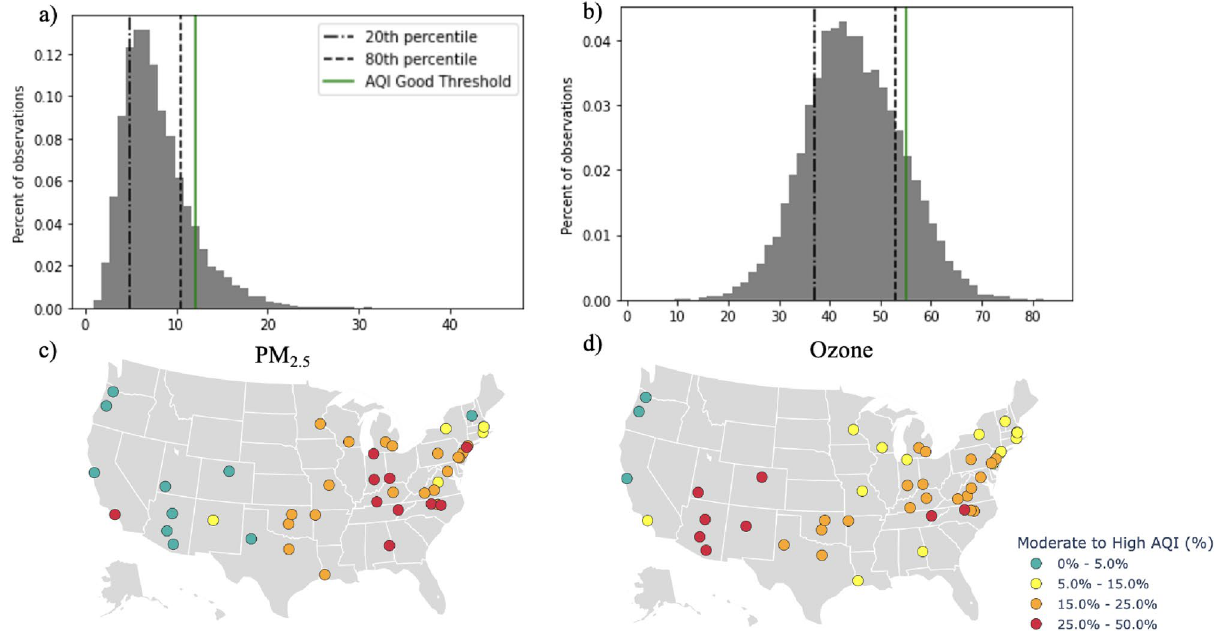
Figure 1. ( a )–( d ) Variations in PM 2.5 and ozone concentrations ( a ) histogram of PM 2.5 concentrations, the dashed line, dotted line and green line represent the 20th percentile: 4.9 µ g / m 3 , 80th percentile: 10.3 µ g / m 3 and AQI good threshold (< 50): 12 µ g / m 3 , respectively ( b ) histogram of ozone concentrations, the dashed line, dotted line, and green line represent the 20th percentile: 36.9 ppm, 80th percentile: 54.9 ppm, and AQI good threshold (< 50): 54 ppm, respectively ( c ) map of university locations colored by percentage of days with moderate-to-high PM 2.5 according to PM 2.5 -specific AQI ( d ) map of university locations colored by percentage of days with moderate-to-high ozone according to ozone-specific AQI. Software: python version 3.9.1, matplotlib version 3.3.3 (histograms 1a, b), plotly version 5.5.0 (maps 1c,